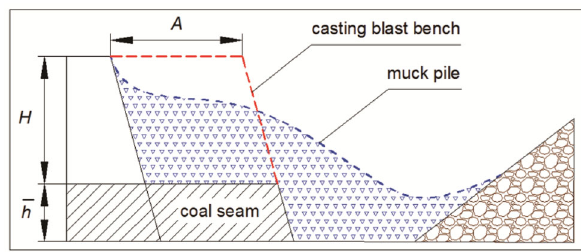
Fig. 3 Profile of the blast casting bench before and after a